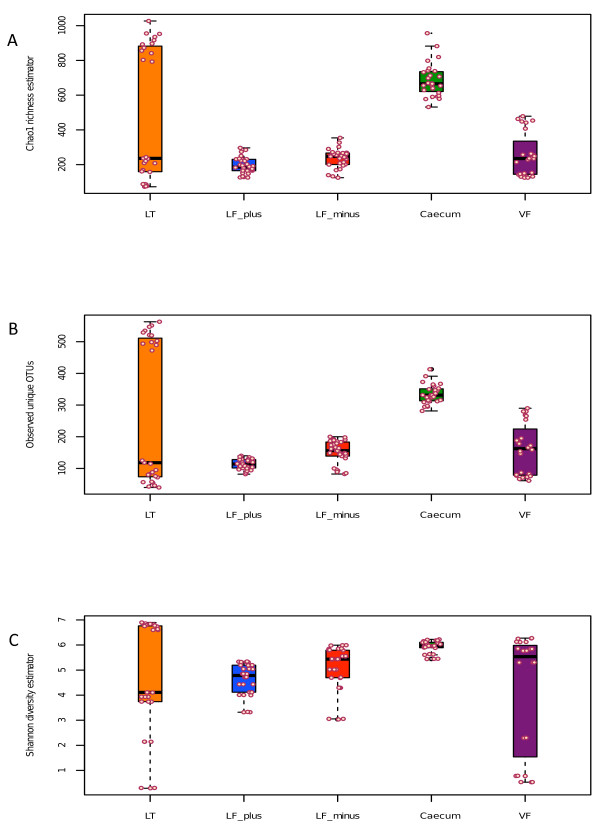
Alpha diversity plots. A: Chao1 richness estimator between sample types and individual samples (circles), LF-plus is bronchoalveolar lavage (BAL) fluids and LF-minus is BAL where the mouse cells have been removed. LT is lung tissue and VF is vaginal flushing, B: Observed unique OTUs and C: Shannon diversity estimator between sample types (s above) and individual samples (circles). The sequences (3350) were randomly even subsampled before calculating the alpha diversity. The boxplots show median, quartile, smallest and largest observations as well as outliers (circles). Significant variation is indicated by * (KW, p < 0.05).